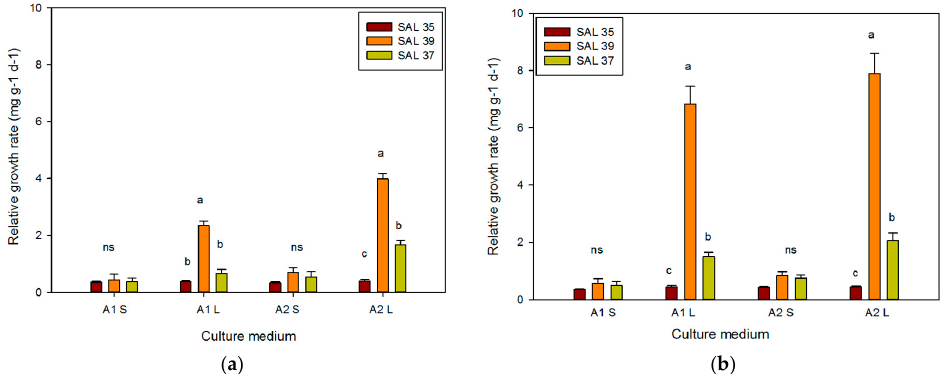
Figure 4. Relative Growth Rate (RGR) of different Capparis spinosa accessions after 30 ( a ) and 60 days ( b ) in different culture systems. Bars represent standard error. Abbreviations: A1 S: substrate A1 solid, A1 L: substrate A1 liquid; A2 S: substrate A2 solid; A2 L: substrate A2 liquid. The different letters reported above the bars grouped for each single treatment indicate statistically significant differences; n.s. not significant (Tukey’s test, p ≤ 0.05). Plants 2019 , 8 , x